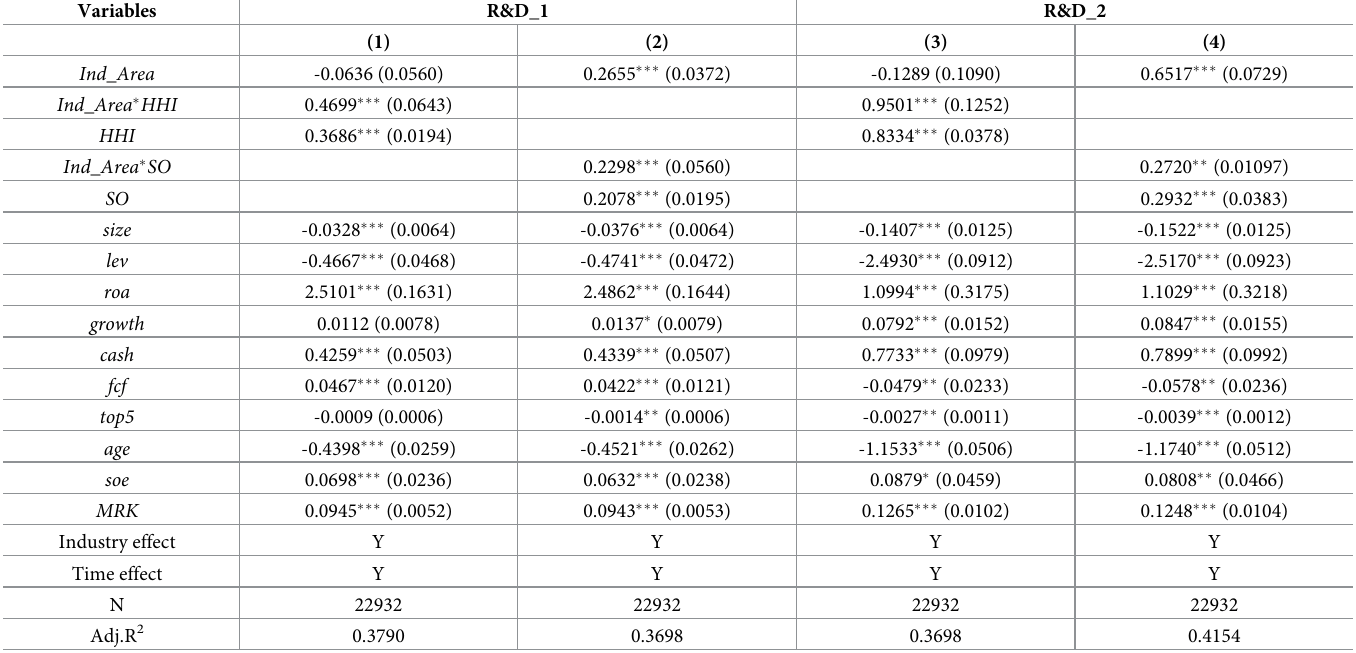
Table 8 reports the regression results of Eq (5). The coefficients of the interaction terms Ind _ Area � HHI and Ind _ Area � SO are 0.4699 and 0.2298, respectively, and both are significant at 1%. This shows that when enterprises face strong industry competition, the ripple effects of Table 8. Industry competition and the effect of CEO